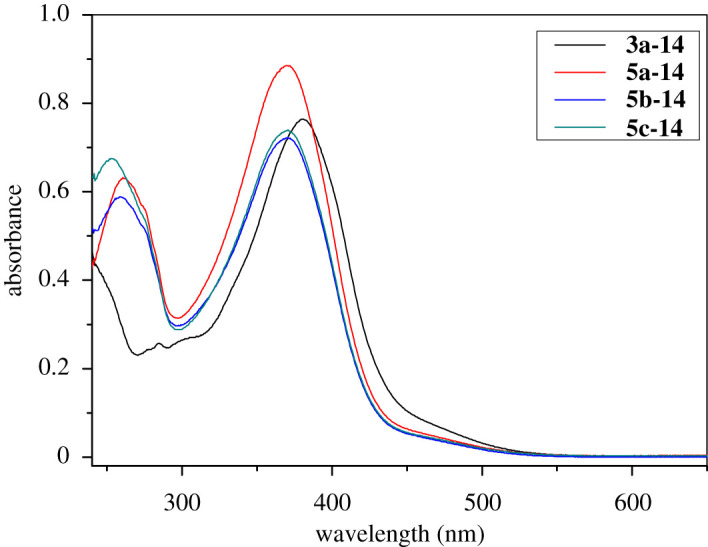
UV–Vis spectra of selected compounds in CH2Cl2 (10−5 M).